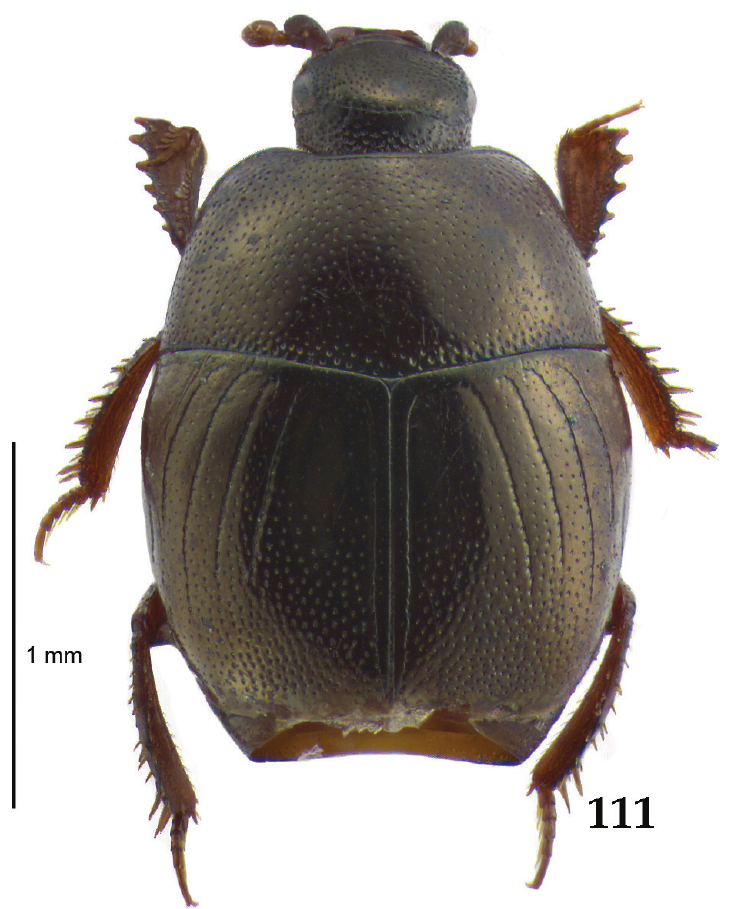
Figure 111. Hypocacculus ( Hypocacculus ) hyla (Marseul, 1864) habitus, dorsal view.